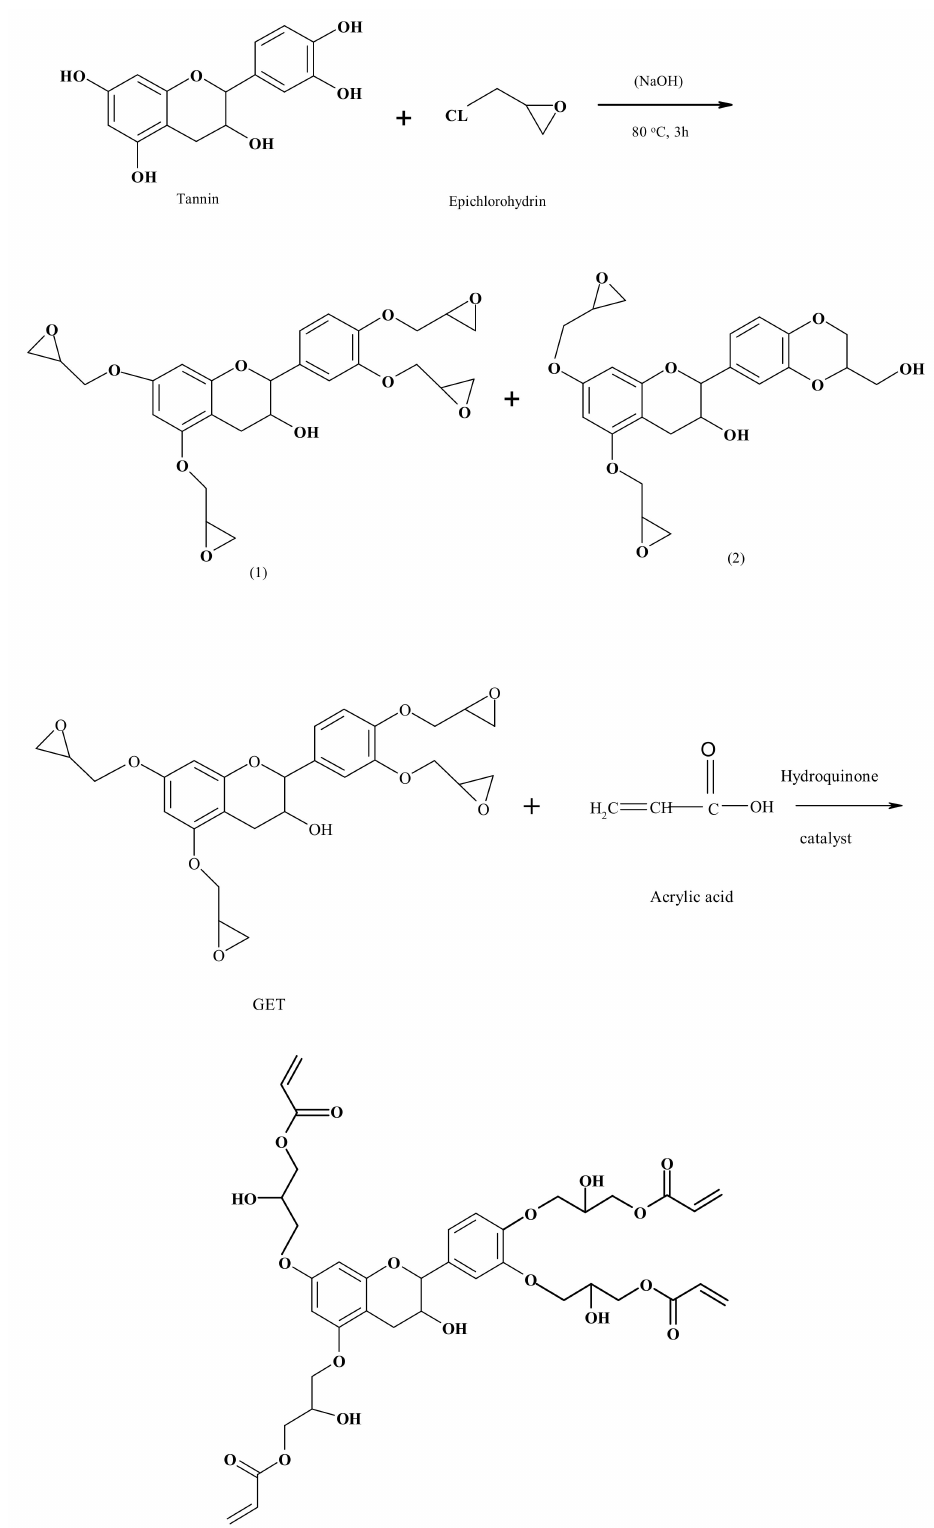
Figure 16. Scheme of the sequence of reactions to prepare the epoxy acrylate resin. The reaction proceeds in two steps: first, the epoxidization of the flavonoid tannin, and second, its reaction with acrylic acid catalyzed by hydroquinone